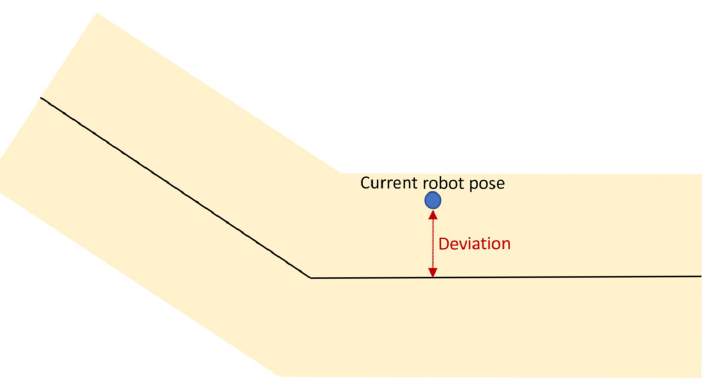
Figure 7. Deviation from the nominal path.